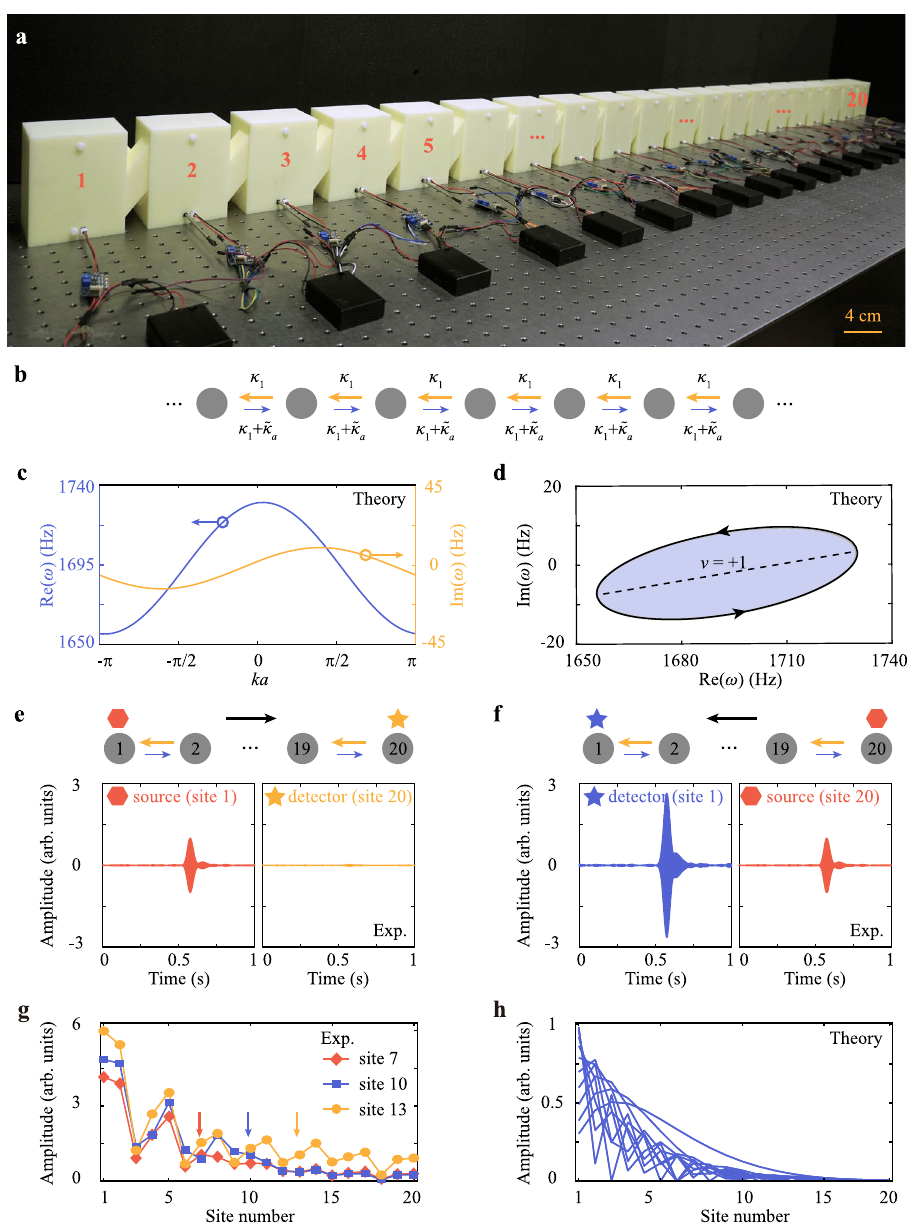
Fig. 3 Observation of acoustic NHSE from single-winding topology. a Photograph of the acoustic crystal composed of 20 cross-linked acoustic resonators. Non-reciprocal coupling is applied between adjacent resonators. b Tight-binding model with nearest-neighbor non-reciprocal couplings κ 1 þ ~ κ a and κ , as denoted by the blue and yellow arrows, respectively. c Real and imaginary parts of the eigenfrequency spectrum calculated with periodic 1 boundary conditions. d The complex eigenfrequency spectrum calculated in ( c ) forms a closed loop in the complex frequency plane, with the winding number v = + 1. The dashed line corresponds to the eigenfrequency spectrum calculated with the open boundary conditions. e , f Transmission measurement of a pulse in the time domain. The top schematic diagram indicates the location of the source (hexagon) and the detector (star) along the acoustic crystal. The measured results are normalized by the amplitude at the source location. g Measured acoustic pressure fi eld distribution at frequency ω = 1713 Hz when the source is located at sites 7, 10, and 13, respectively. The measured results are normalized by the amplitude at the source location (indicated by little arrows). h Superposition of the calculated fi eld distributions of eigenstates in the fi nite